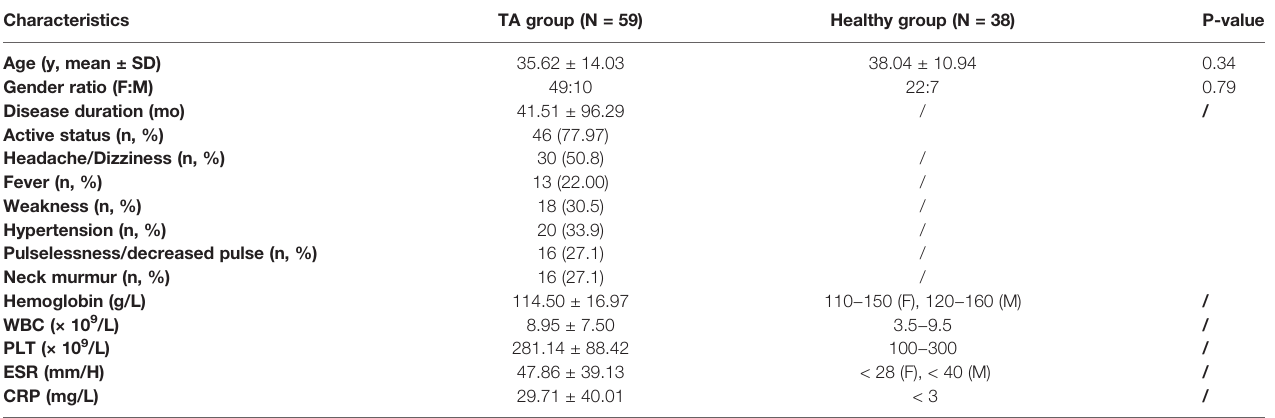
TABLE 2 | Baseline clinical characteristics of the patients recruited for serum detection.